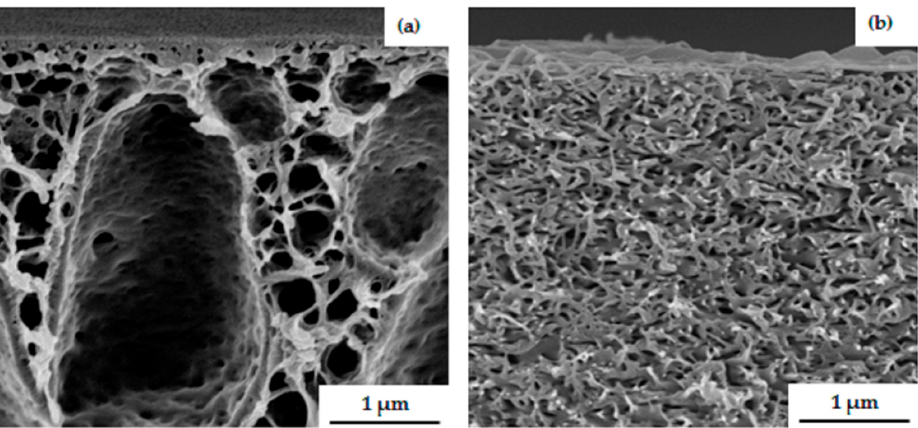
Figure 8. SEM images of the cross-section of the membrane prepared from 24 wt % PS 81 -PSMA 19170 in THF/DMF 50/50 wt % at ( a ) 5 s, ( b ) 25 s time of evaporation.